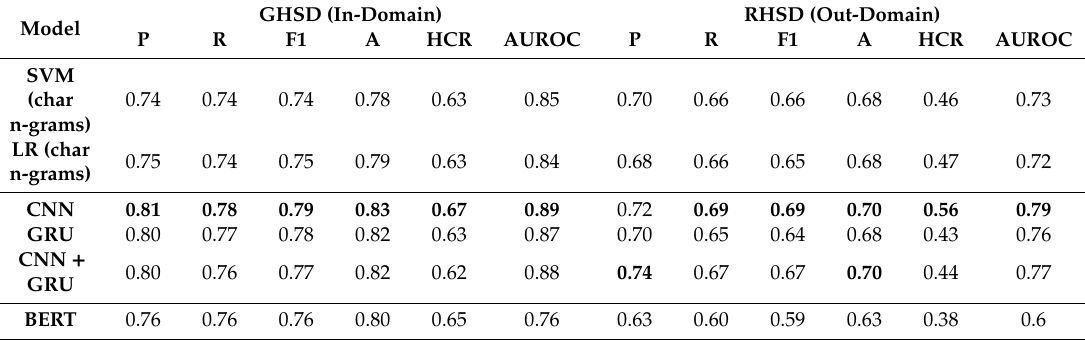
Table 3. Evaluation results of the experimented models. The best result for each metric is boldfaced *. GHSD (In-Domain) RHSD Model